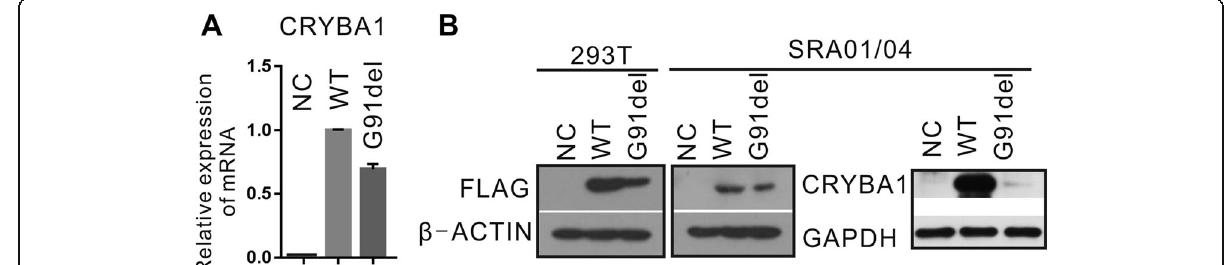
Fig. 4 The CRYBA1 p.G91del mutation reduced its expression in two cell lines. ( a ) After the WT and deleted forms of CRYBA1 cDNA constructs were transfected into SRA cell lines, the relative mRNA level of CRYBA1 was quantified by qPCR. β -Actin was used as internal control. The WT group was used as sample control (n = 3). ( b ) The protein levels of CRYBA1 were measured by Western blot. In 293 T and SRA cells, the